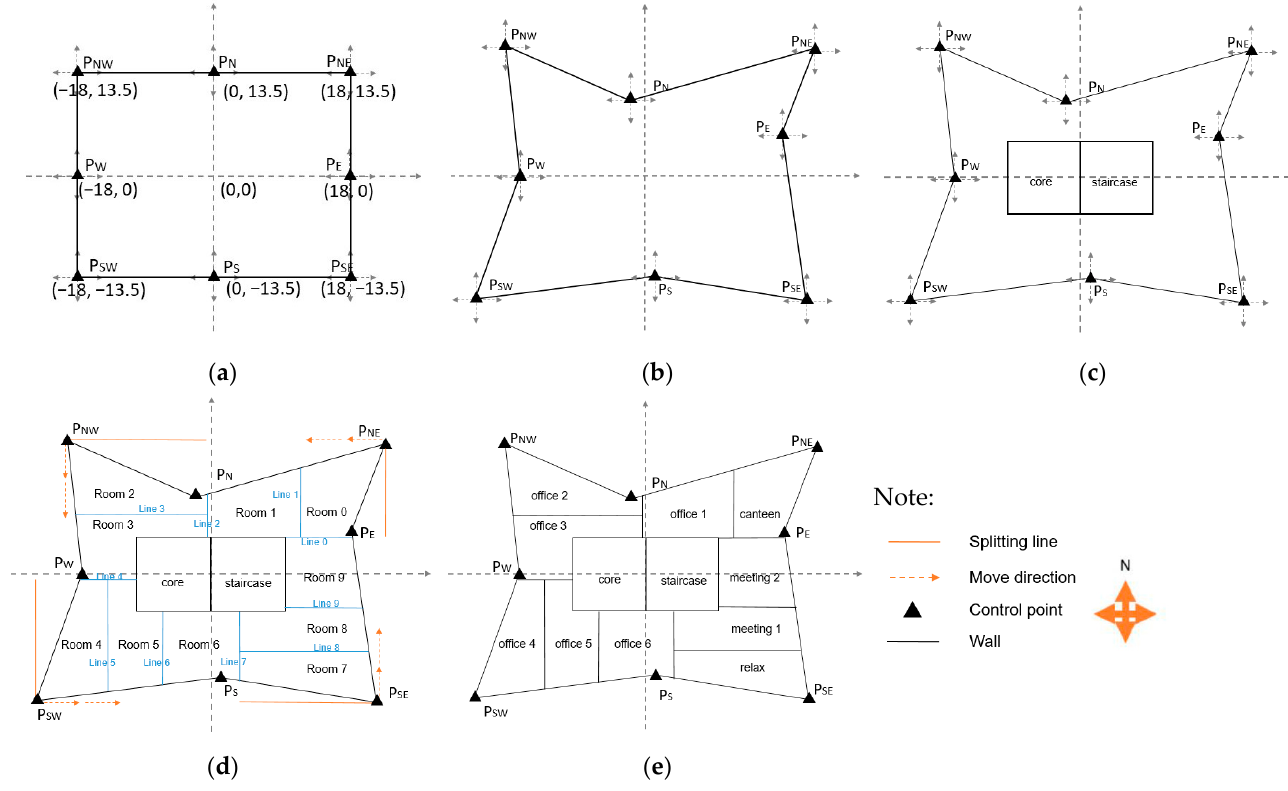
Figure 3. Procedure for generating layouts. ( a ) Original layout; ( b ) Changing the layout boundary using control points; ( c ) Locating the core and staircase in the middle; ( d ) Splitting the remaining layout into 10 rooms with the same area; ( e ) Allocating functions to the 10 rooms.